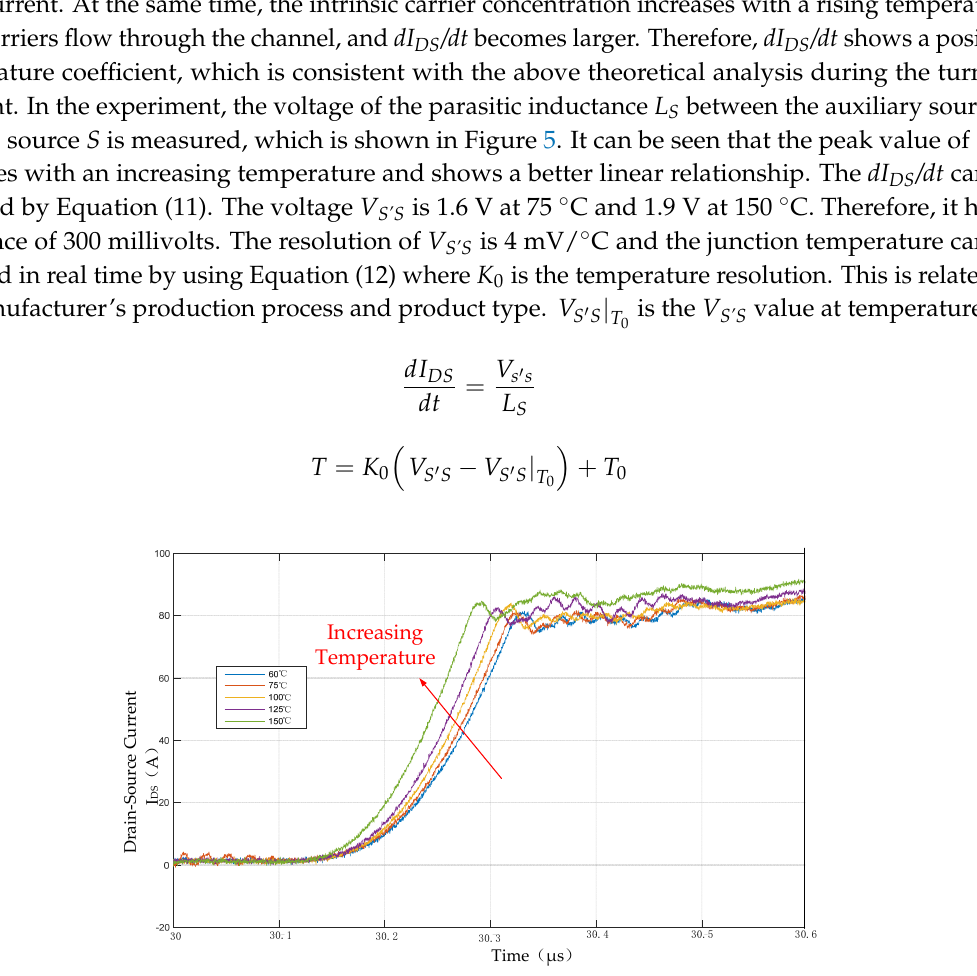
Figure 4. Waveforms of the drain ‐ source current at different temperatures.